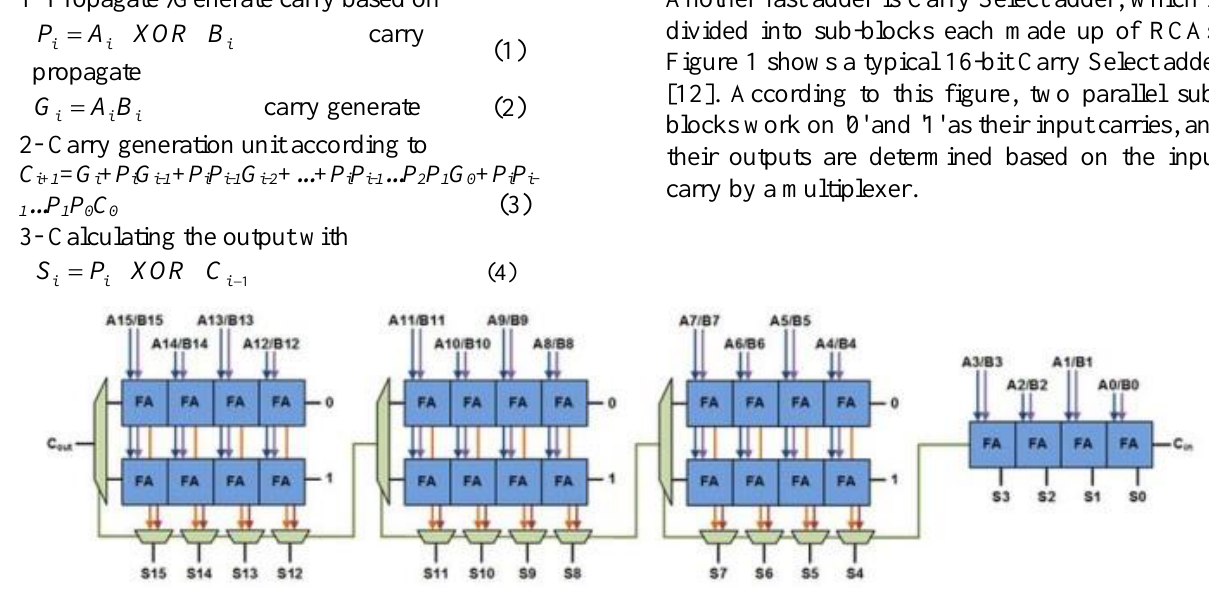
Figure 1. A typical 16-bit Carry Select adder.